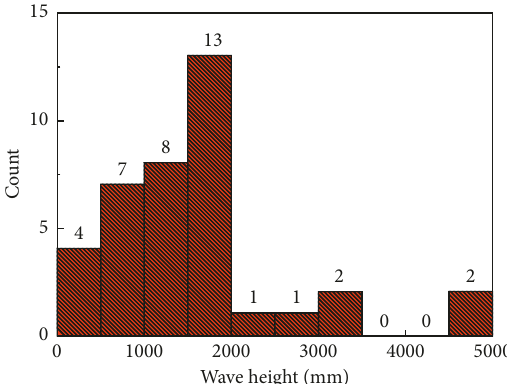
Figure 9: Simulated wave height distribution of near-fault ground motion. Table 5: RMS and gauge wave heights of excitation wave heights for near-fault ground motions. Vertical storage